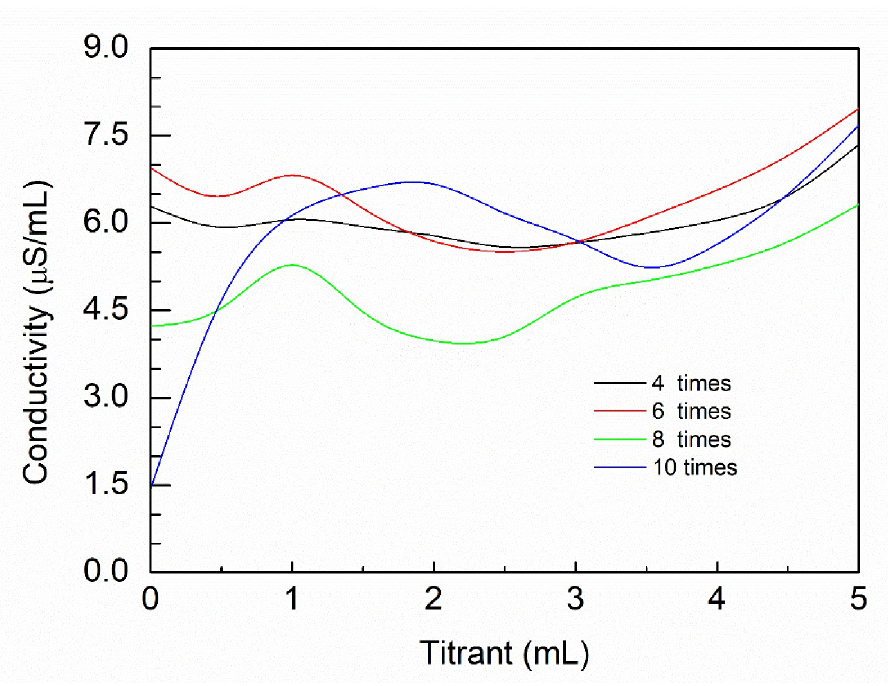
Fig 6. Influence of washing times on conductivity